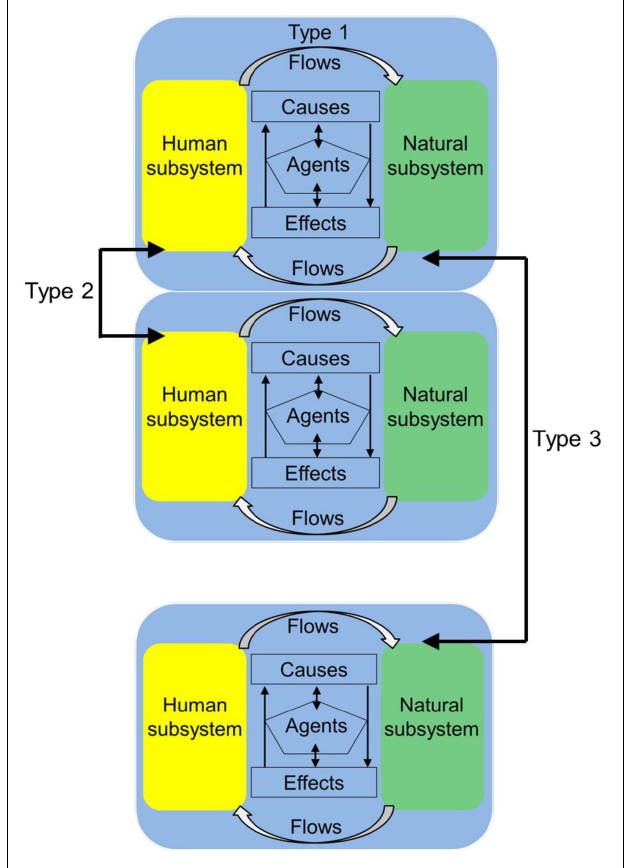
FIGURE 1 | Diagram illustrating metacoupling: human-nature interactions (arrows) within a particular or local social-ecological system (Type 1) as well as between adjacent systems (Type 2) and between distant systems (Type 3)